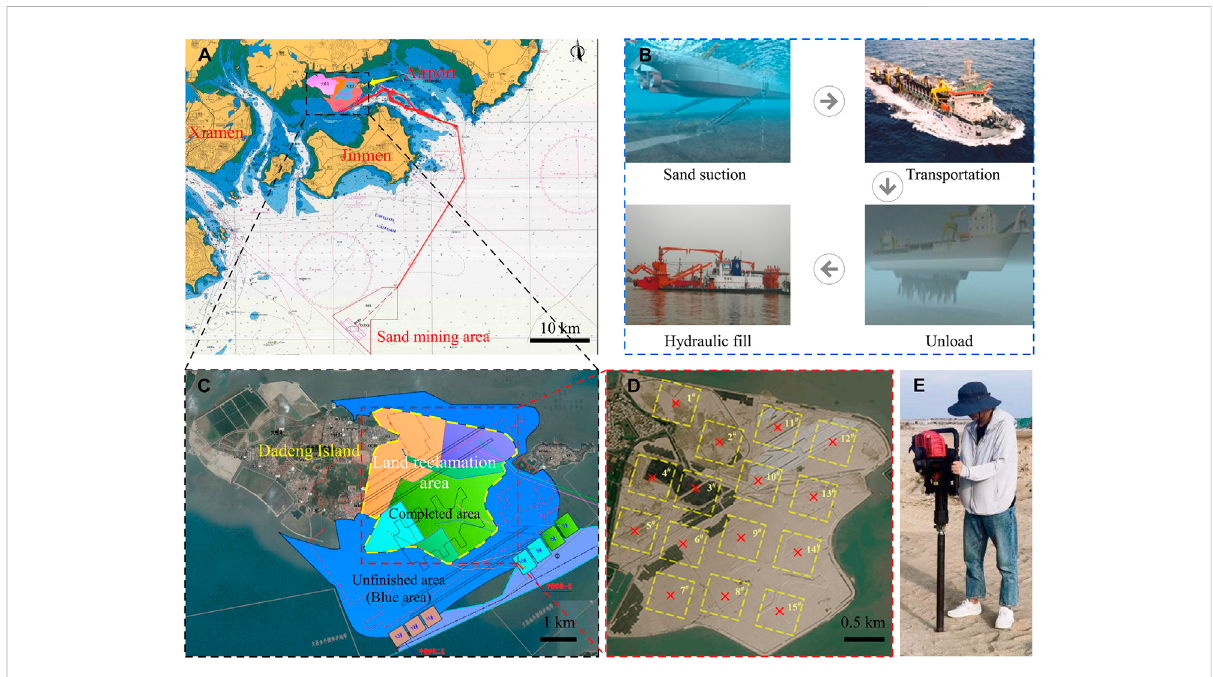
FIGURE 1 The location of theairport underconstruction and thesamplingdiagram: (A) location ofthe airport; (B) construction process with sea sand; (C) land reclamation area; (D) sampling diagram; (E) sampling photo.